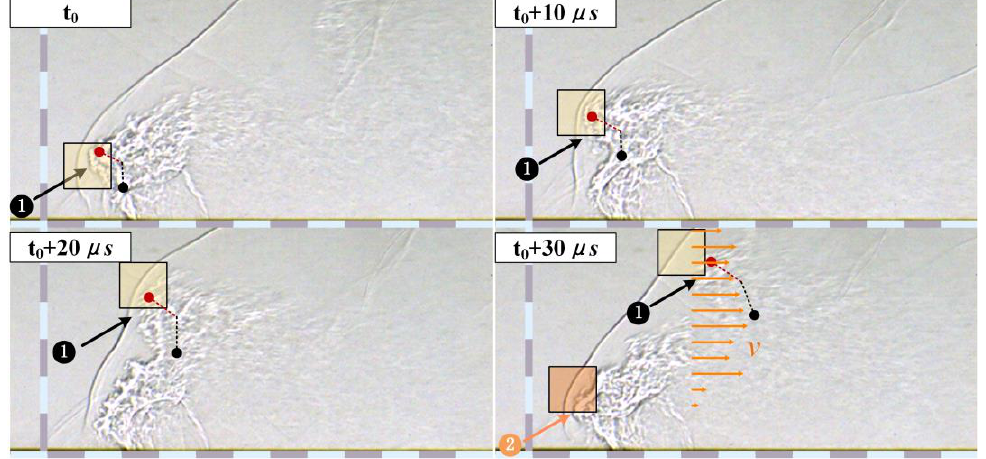
Figure 10. Spatiotemporal evolution of the flow field during Test 15.